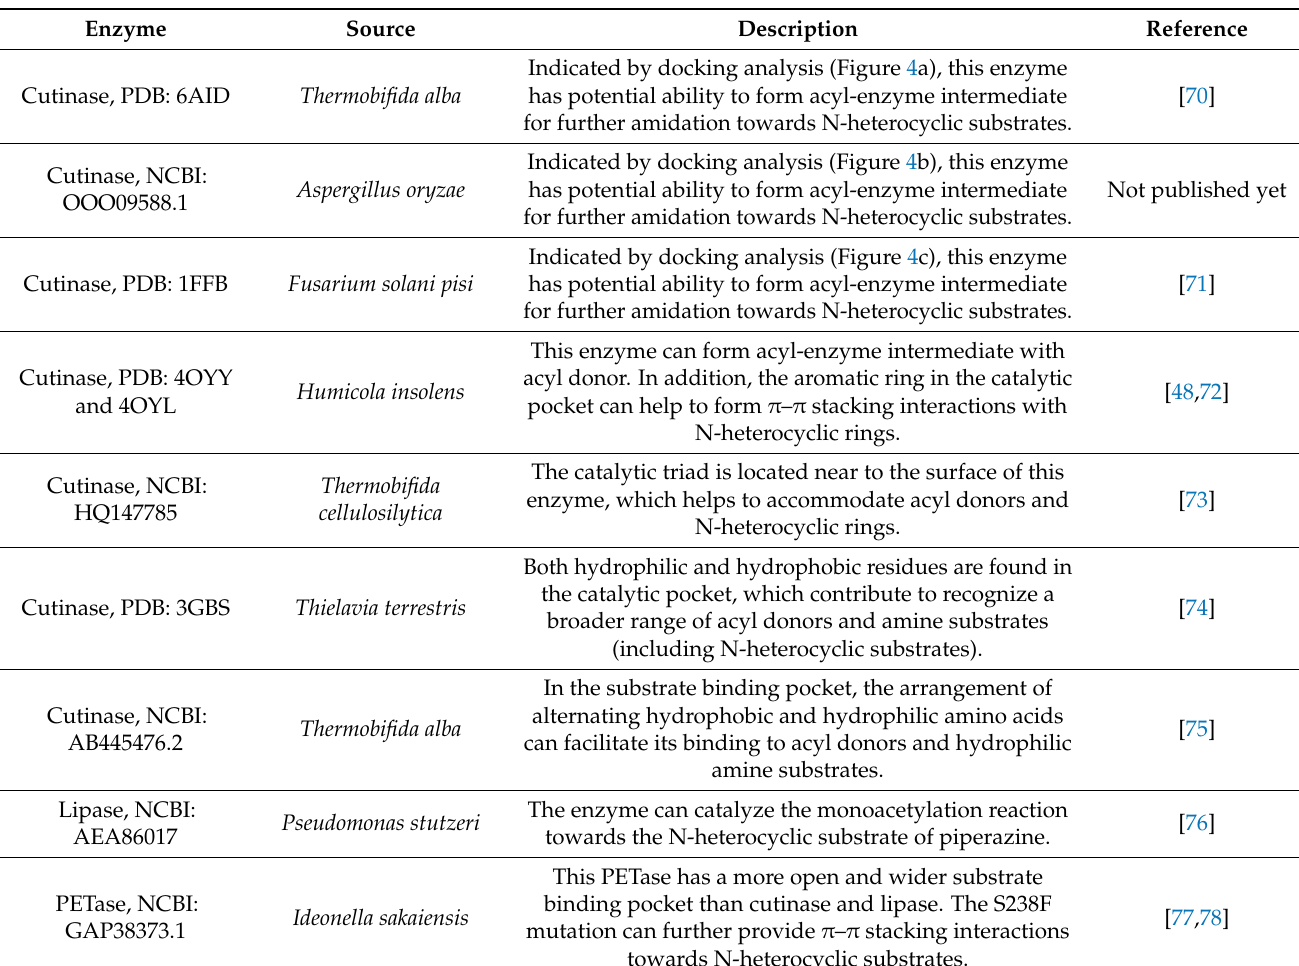
Table 1. Candidate cutinases and lipases for the bio-amidation towards N-heterocyclic substrates.